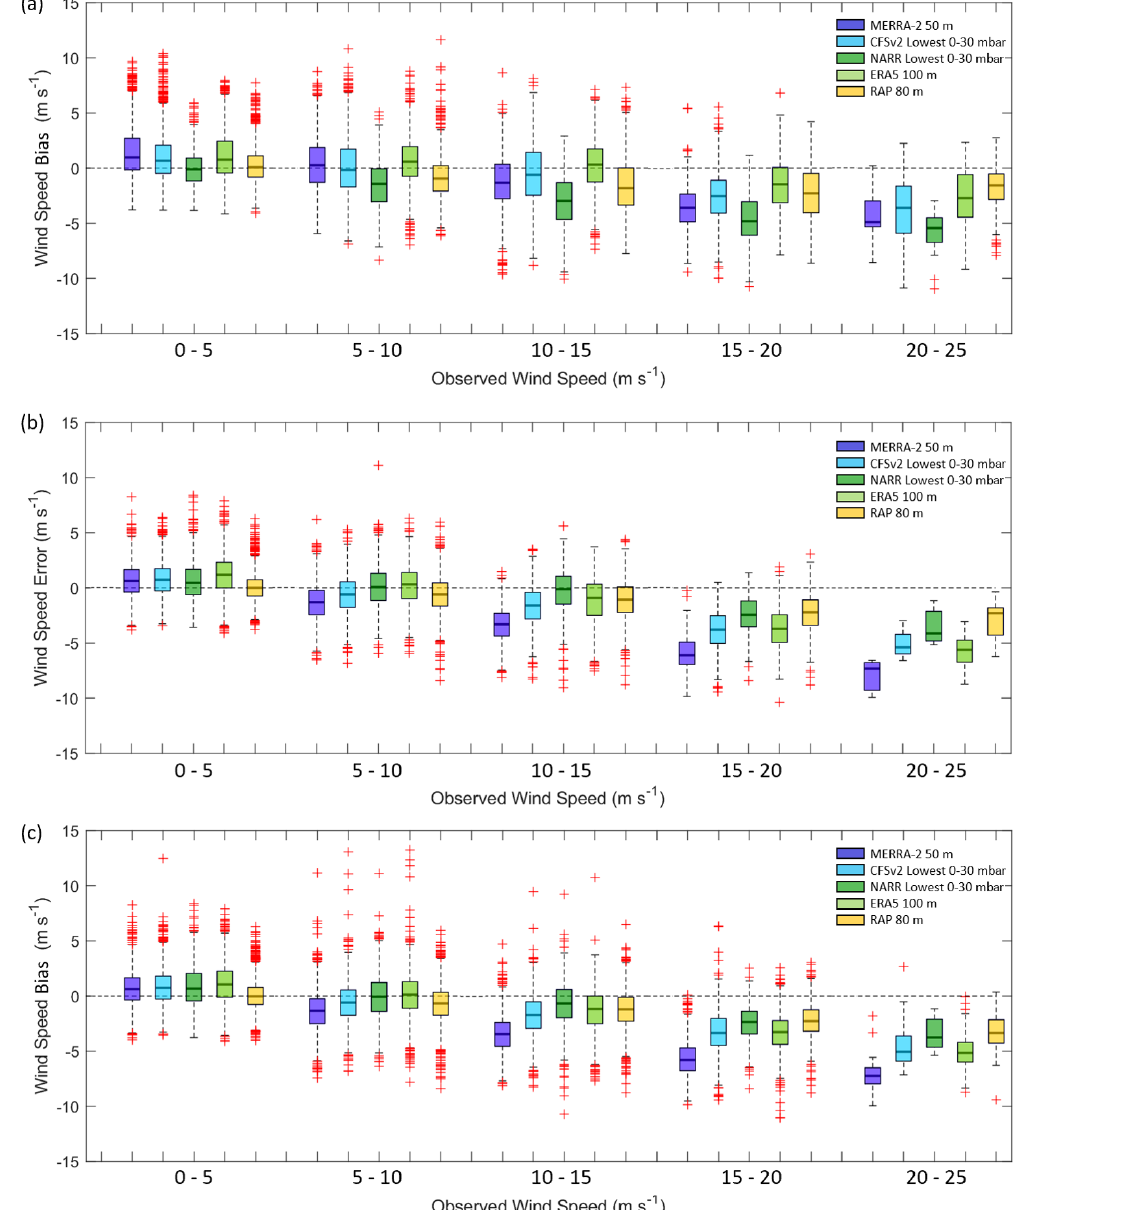
Figure 10. Model wind speed bias according to observed wind speed at (a) Humboldt, (b) Morro Bay during the overlapping Humboldt period, and (c) Morro Bay during the full seasonal